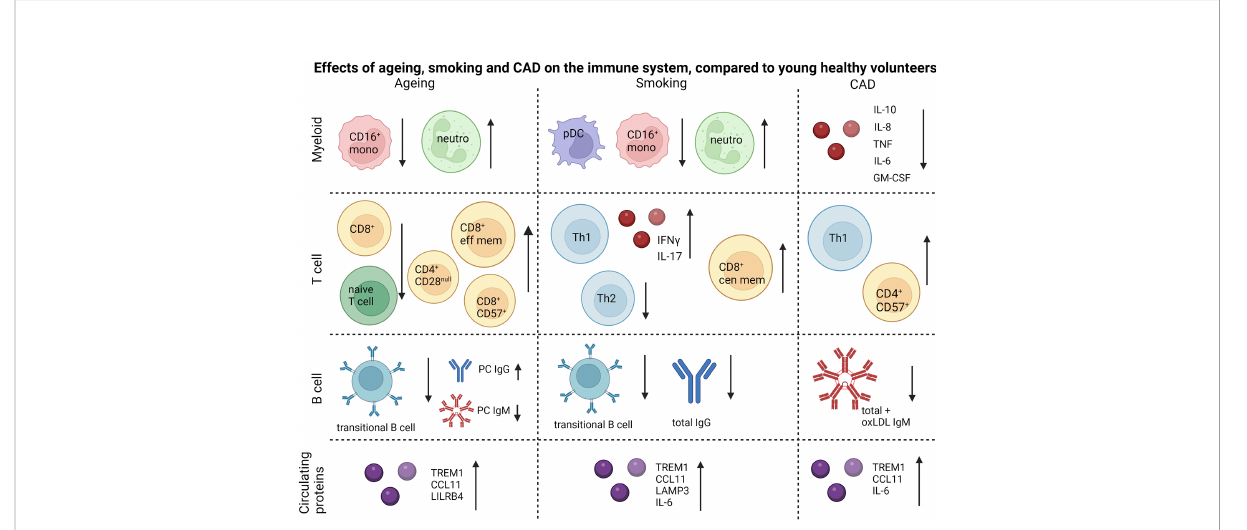
FIGURE 8 Summary of the main differences caused by ageing, smoking and CAD. Figure is created using